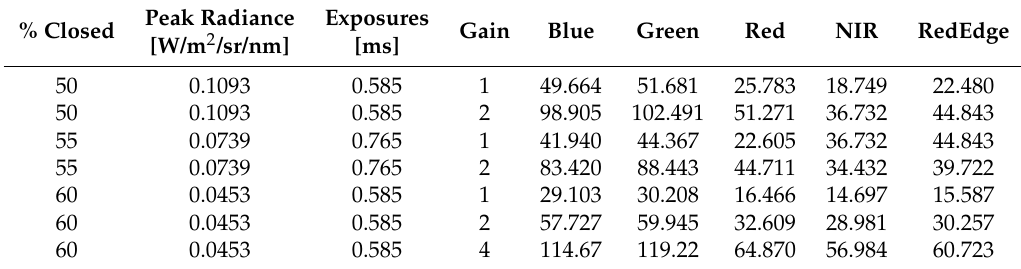
Table 7. RedEdge-3 12-bit digital count error for various light level, gain and exposure combinations. Digital count error was computed using vignette and row-corrected imagery from an integrating sphere. A positive correlation is seen between digital count error and both gain and exposure time, while a negative correlation is seen for digital count error and light level.